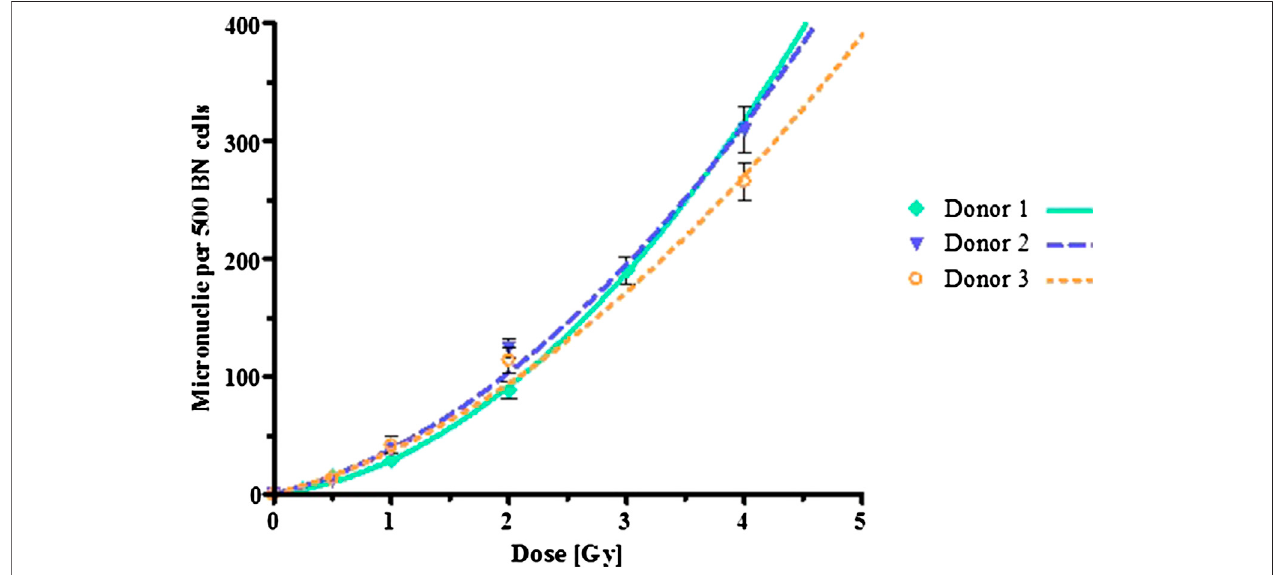
FIGURE 4 | Dose-response curves following exposure to 60 Co γ -rays radiation. The error bars are the standard deviations of the mean micronuclei formation per dose point.